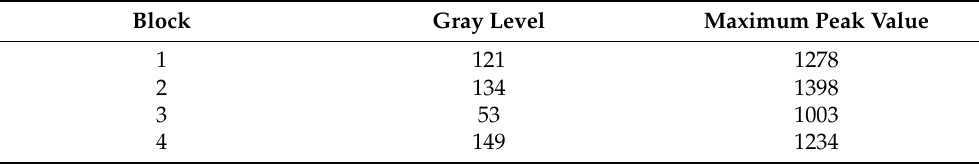
Table 1. Gray level and its maximum peak value.